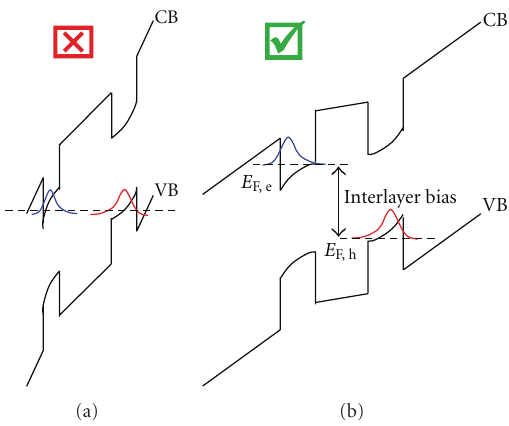
Figure 2: The band bending shown on (a) is not possible to achieve in GaAs for a closely spaced EHBL. The electric field in the barrier would be too high to sustain or even obtain self-consistently by modulation doping alone. One has to resort to making the electrochemical potential discontinuous (as shown on (b)). This was already understood in 1992.